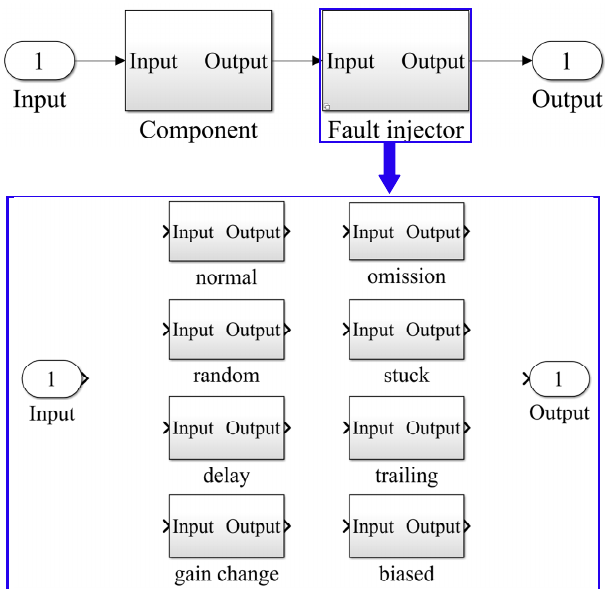
Figure 5. Simulink model of the fault injector.